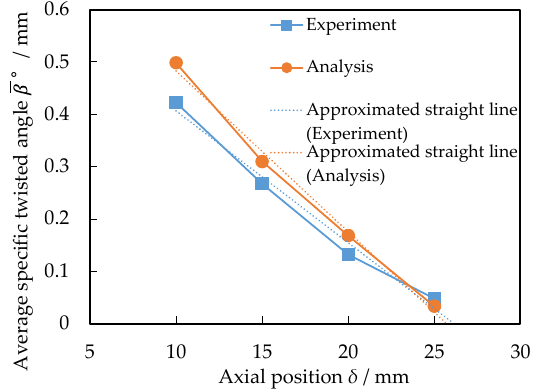
Figure 10. The effect of axial position on the twisted angle.